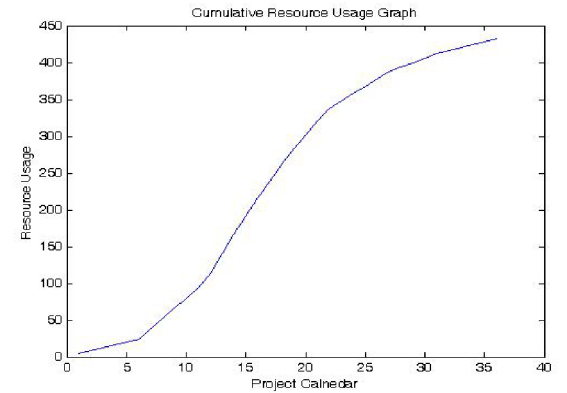
Figure 10. Cumulative resource usage for resource 1 of experiment 1 (relaxed resource constraint)